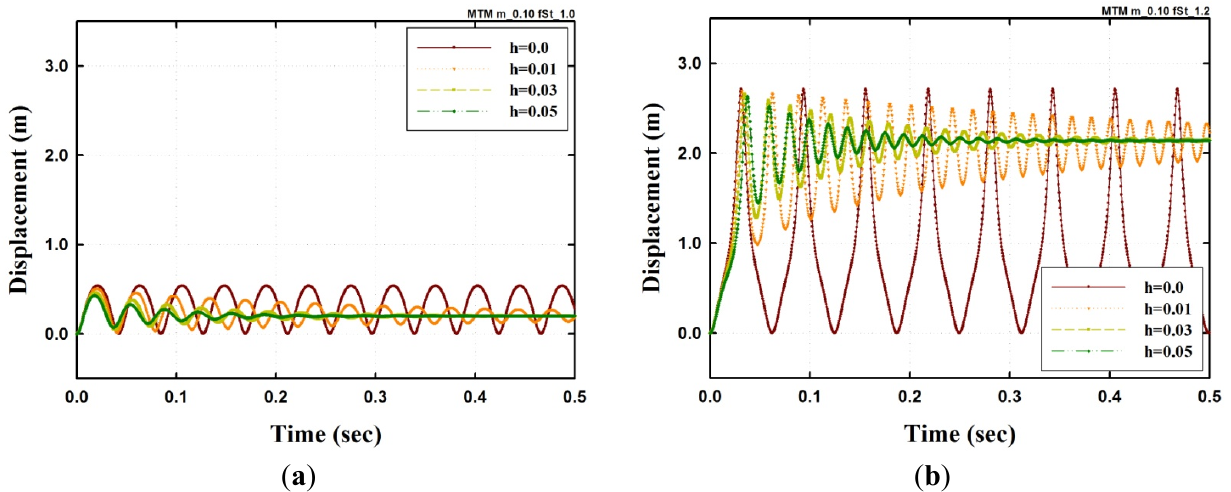
Figure 4. Dynamic analysis results of a damped SFN model under a step excitation